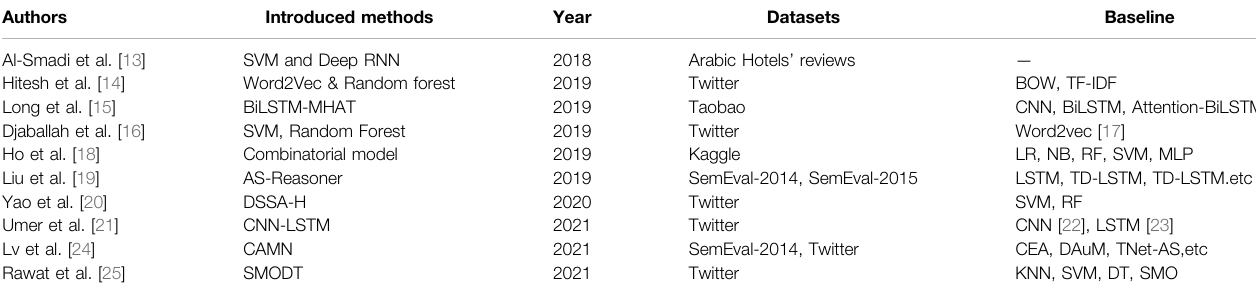
TABLE 1 | Maching learning in sentiment analysis. Authors